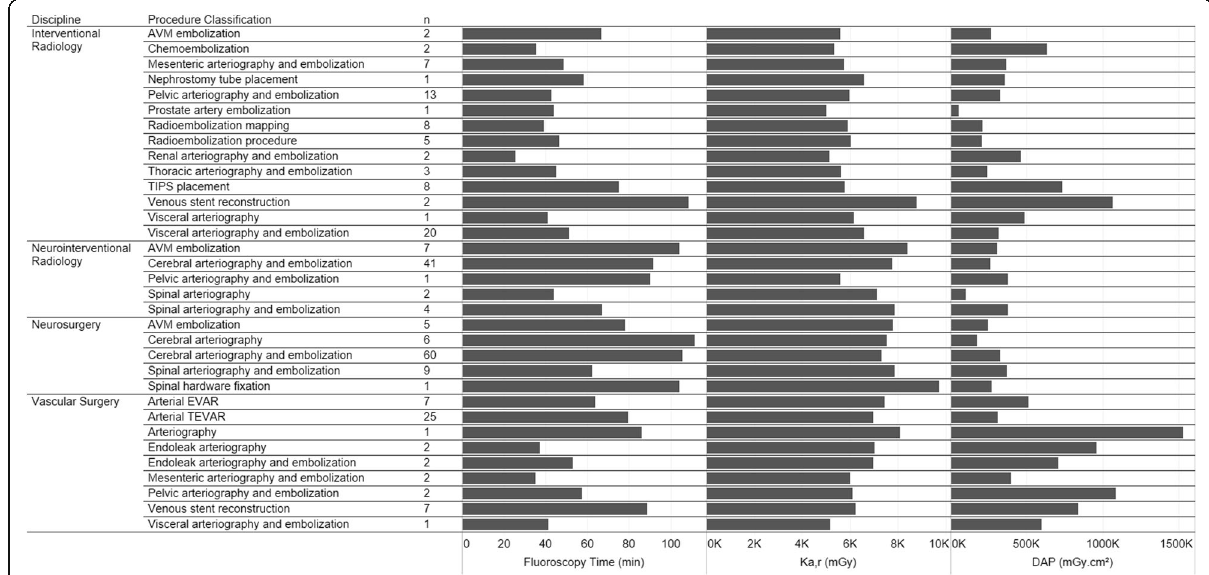
Fig. 1 Mean FT, DAP, and K a,r distribution by intervention type and medical discipline (FT = fluoroscopy time, DAP = dose area product, K a,r. = reference point air kerma, AVM = arteriovenous malformation, TIPS = transjugular intrahepatic portosystemic shunt, EVAR = endovascular aneurysm repair, TEVAR= thoracic endovascular aortic